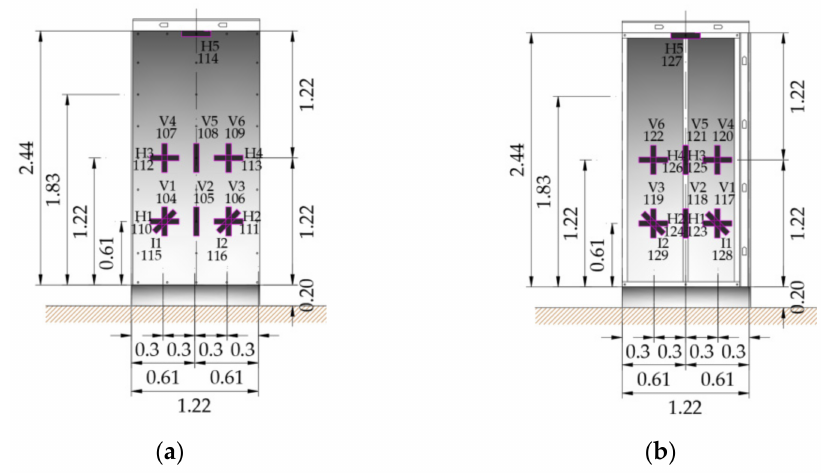
Figure 13. Strain Gauges identification on Wall 3: ( a ) North face; ( b ) South face.